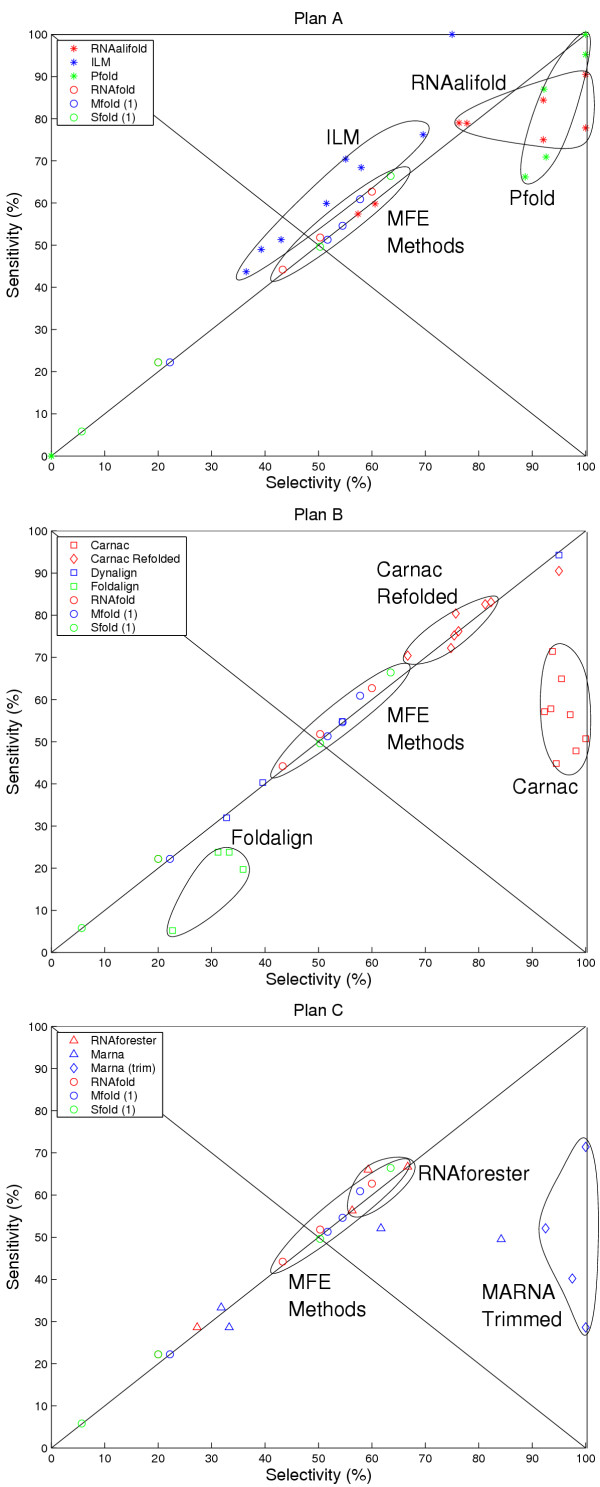
ROC plots. We use ROC (receiver operating characteristic) plots to simultaneously display both sensitivity and selectivity for plans A, B and C respectively. Accuracies of the MFE methods (MFold, RNAFold and SFold) are shown in each plot to provide a base-line. Points on the line X = Y are as sensitive as they are selective, points below this line indicates a greater selectivity, points above indicate greater sensitivity. Points below the line X = 100 - Y are worse than "random" assignments; Assuming base-pairs are independent of each other (this is false for base-pairing). Points in the top right corner are "perfect" predictions. Interestingly many algorithms form characteristic clusters in these plots. Where the variance is sufficiently small these have been indicated with a closed curve.